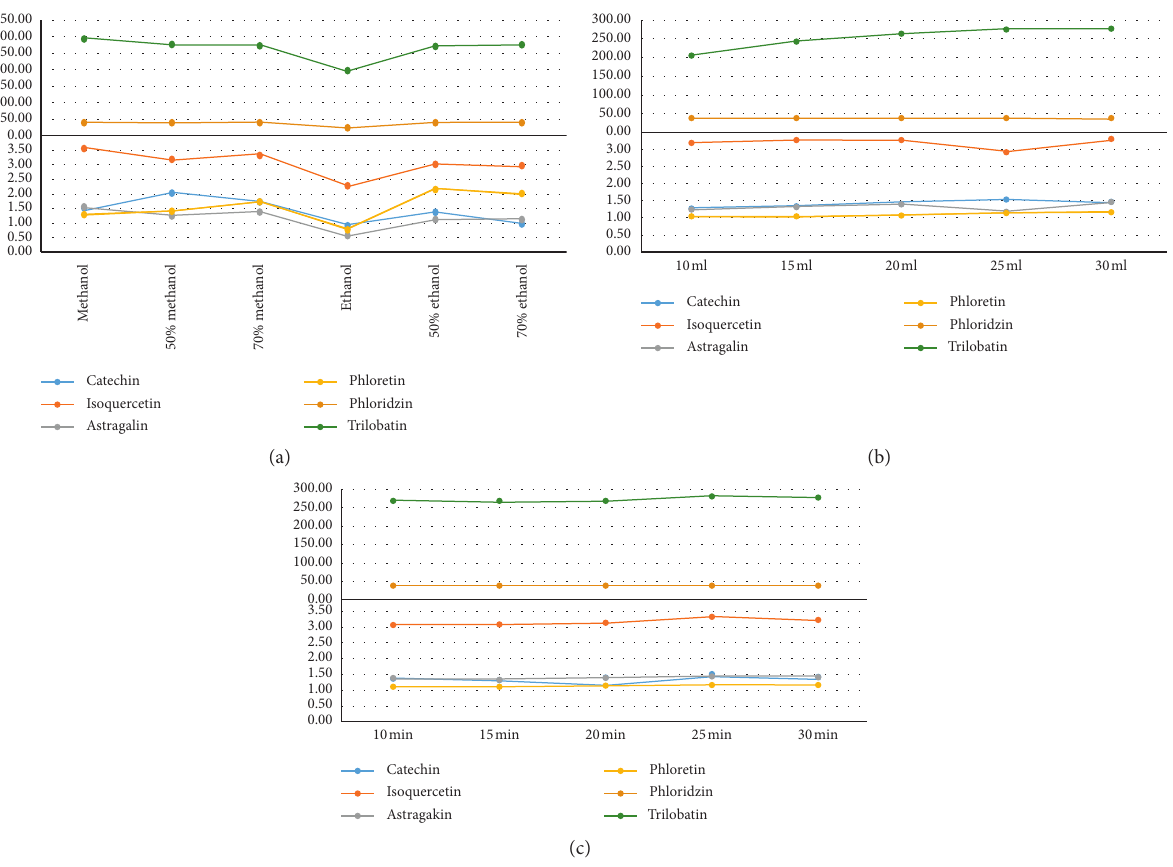
Figure 3: Optimization of LP extraction conditions. (a) Solvent type (methanol, 50% methanol, 70% methanol, ethanol, 50% ethanol, and 70% ethanol). (b) Solvent volume (10, 15, 20, 25, and 30mL). (c) Ultrasonic time (10, 15, 20, 25, and 30min).